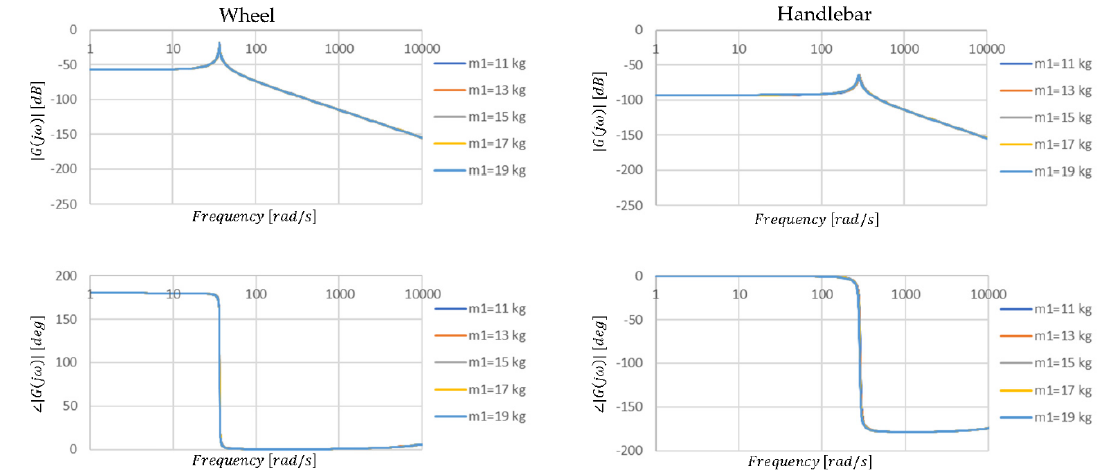
Figure 11. Amplitude and phase characteristics of the transmittance of the steering angle position when the parameter value is changed m 1 . Table 5. The values of the parameters read from the graphs shown in Figure 11.